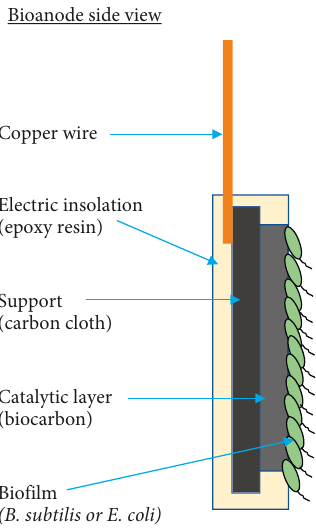
Figure 1: Bioanode side view with a configuration of support + catalysts +